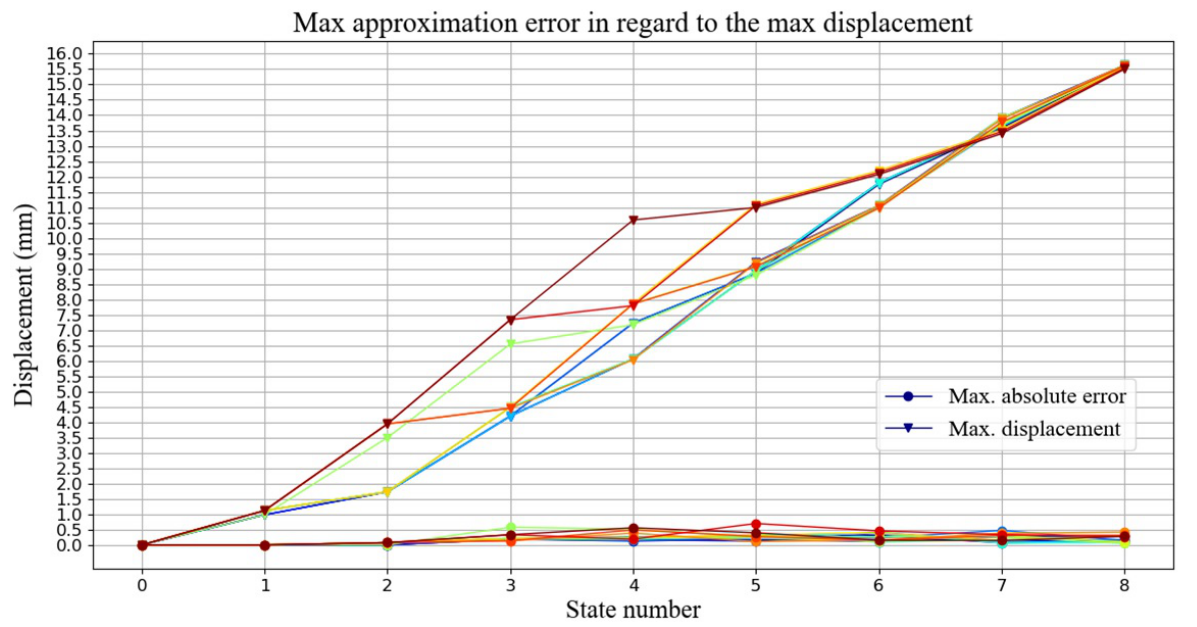
Figure 17. Maximum prediction error and maximum displacement for the DMD approximation with topology